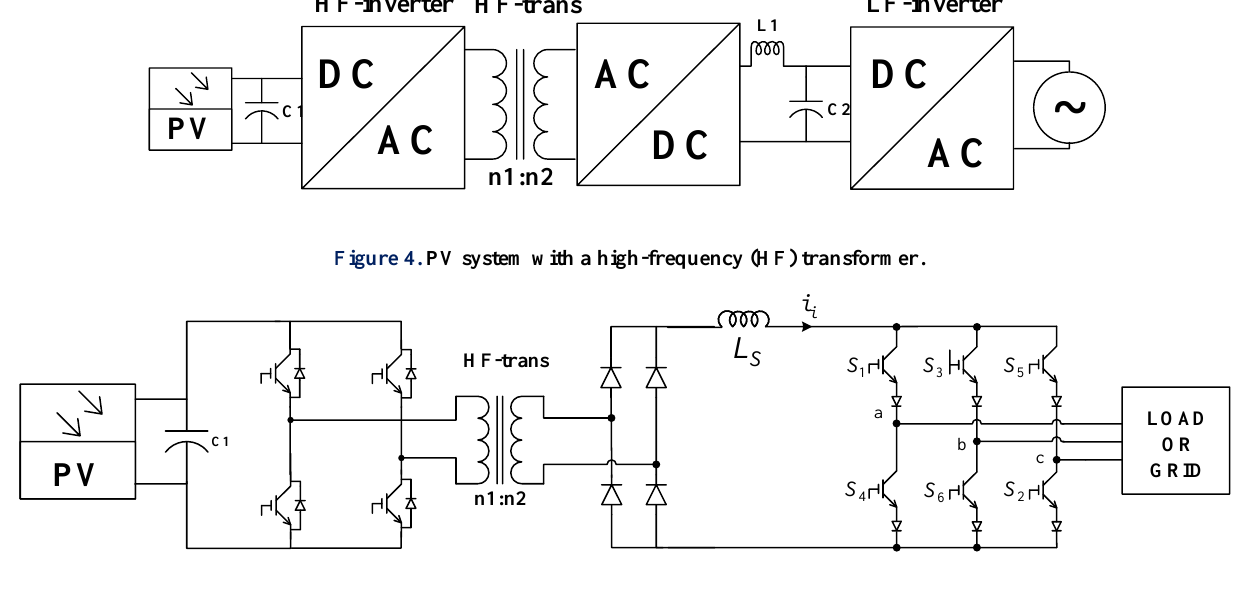
Figure 5. The proposed topology with Current-Source